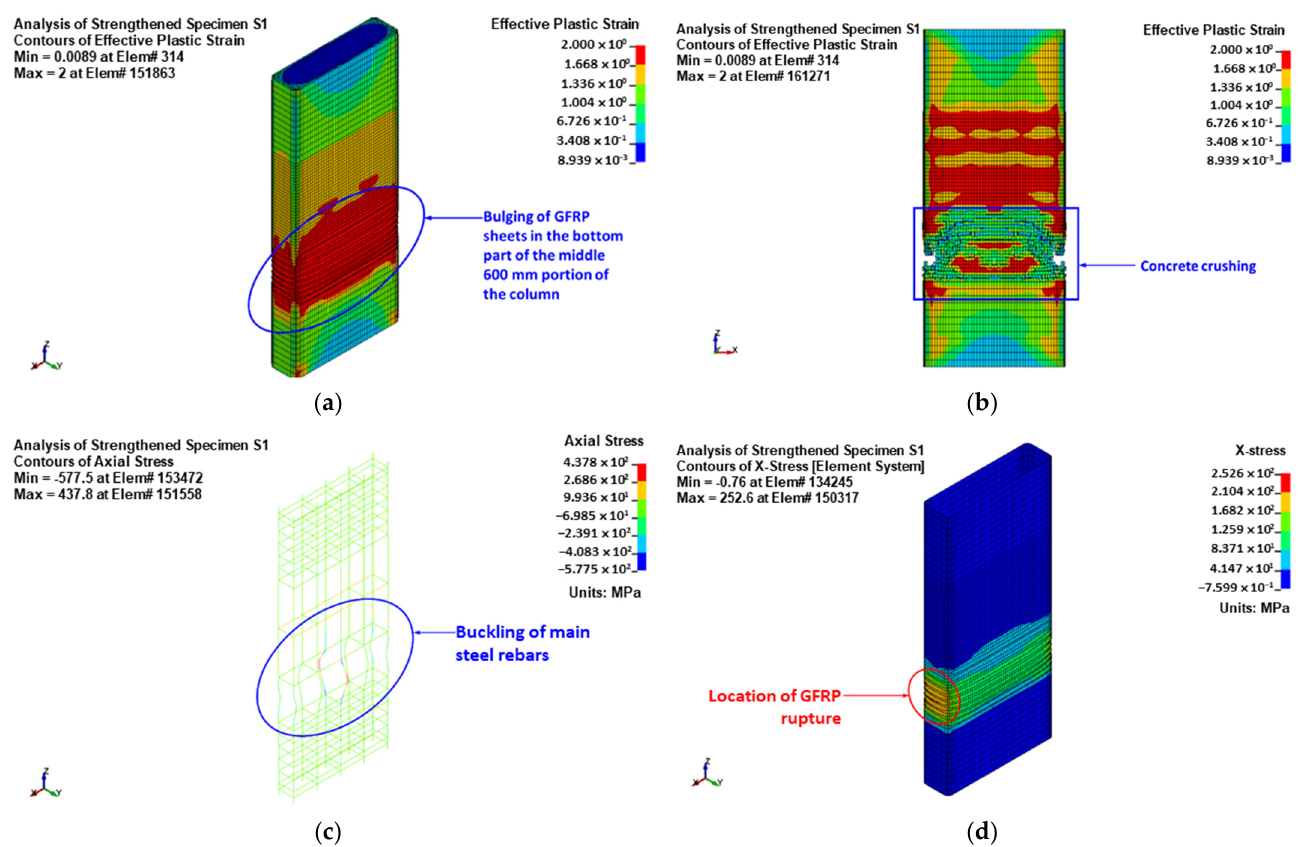
Figure 16. Numerically predicted failure mode for upgraded column S1: ( a ) bulging of GFRP sheets at maximum load; ( b ) concrete damage contours; ( c ) stresses in reinforcement cage; ( d ) stresses in the fiber direction for GFRP sheets.